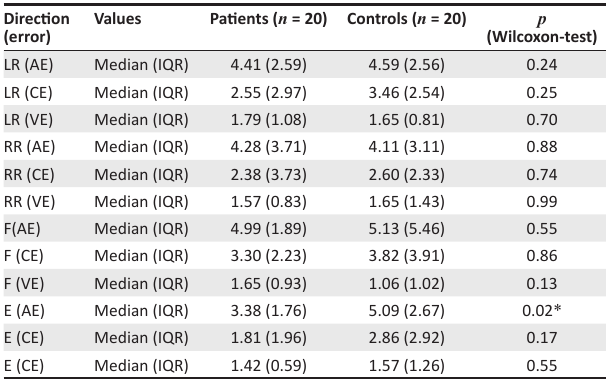
TABLE 2: Median differences of scores.